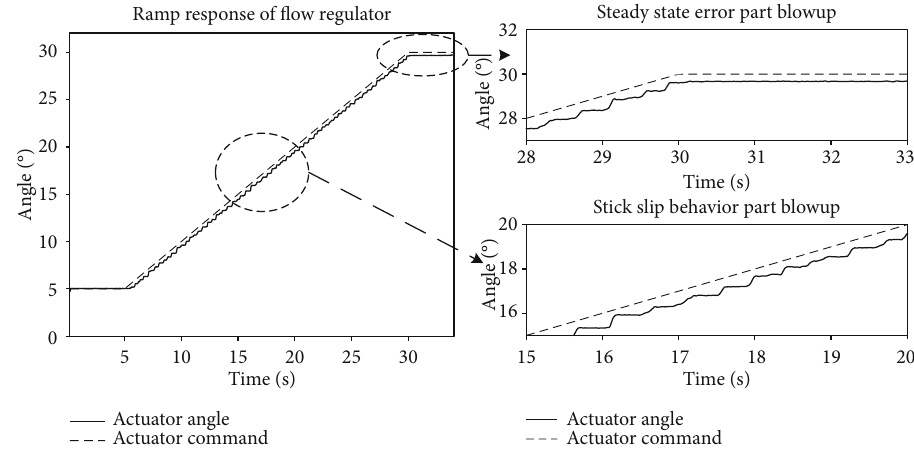
Figure 2: Stick slip behavior and steady state error of the fl ow regulator.